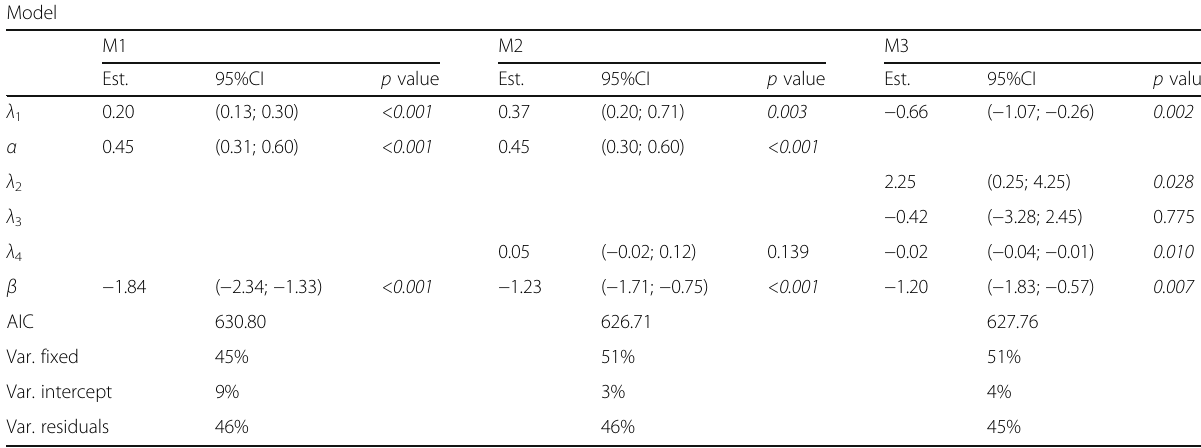
Table 2 Summary of the estimated parameters, resulting AIC and relative variance of the response logAGR explained by the fixed effects, random intercepts and residuals (unexplained) for the three tested models